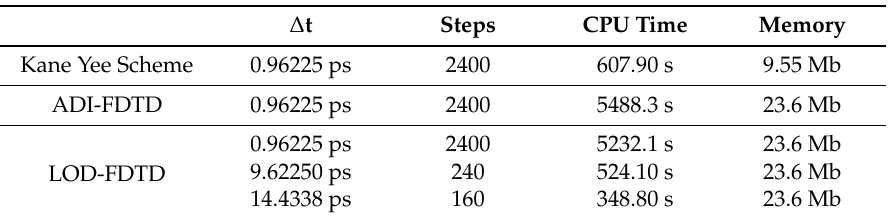
Table 5. Time step modeling and computational effort